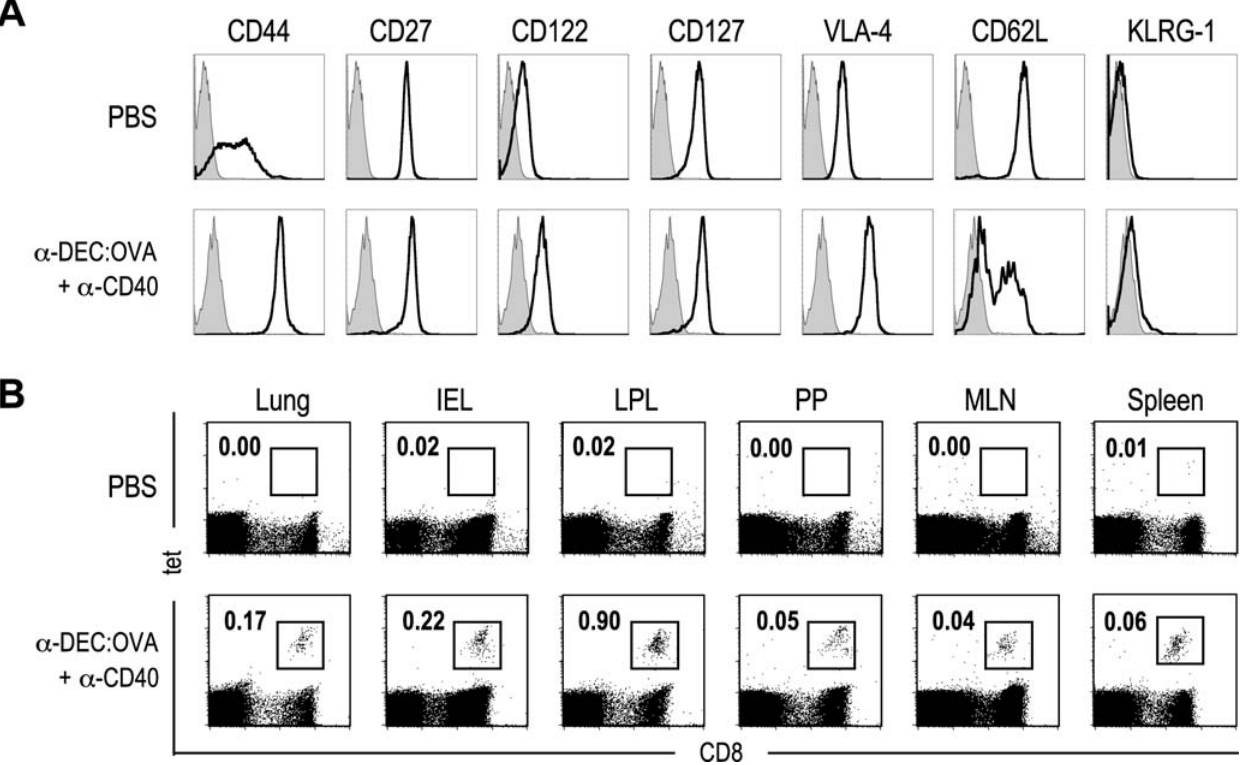
Figure 2. Characterization of memory CD8 + T cells following DEC-205 targeting of OVA. (A) Phenotype of OVA-specific memory CD8 + T cells at d 60 after priming with anti-DEC:OVA + anti-CD40. OVA-specific cells were enriched using MACS sorting as described in the methods and gated as tet + CD8 + cells. Naı¨ve cells are not tetramer binding cells and were gated as CD44 low CD8 + cells. (B) Memory CD8 + T cells were identified in the indicated tissues: lung, intestine (IEL, LPL), Peyer’s patches (PP), mesenteric lymph nodes (MLN), and spleen at d 60 after priming with anti- DEC:OVA + anti-CD40. Numbers are % of lymphocytes.